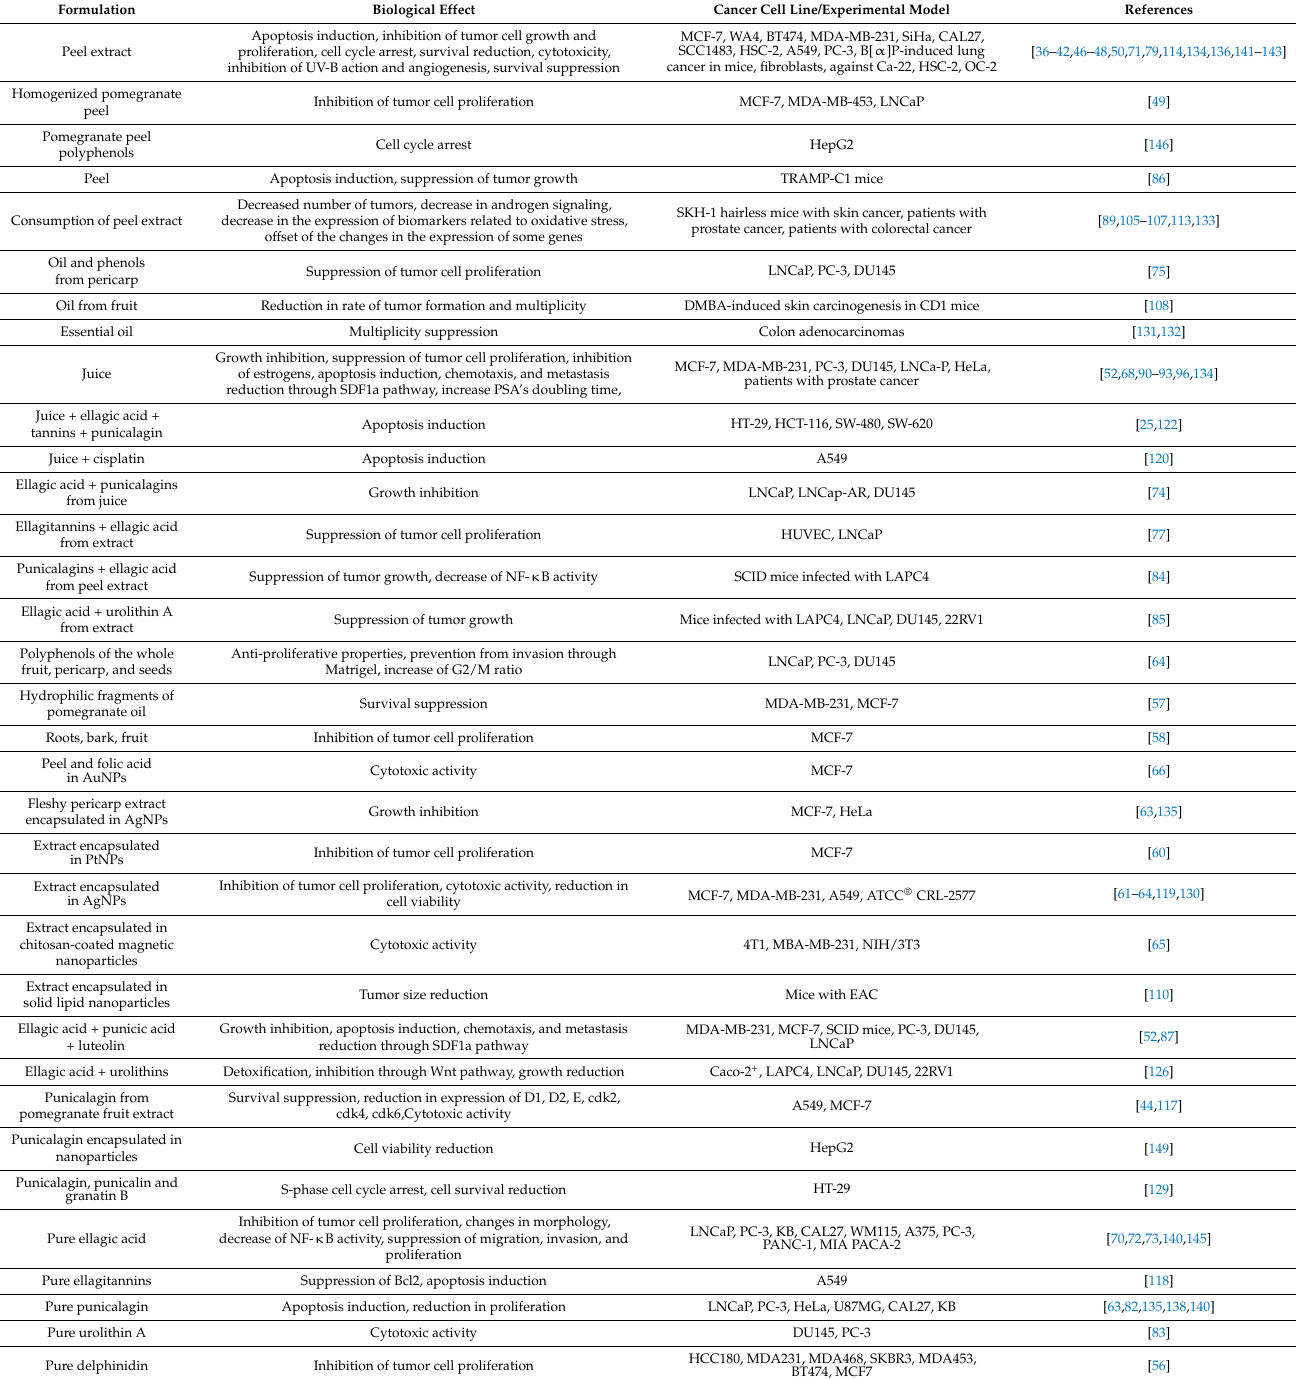
Table 1. Examples of pomegranate parts examined on various cancer cell lines and experimental models and their potential biological